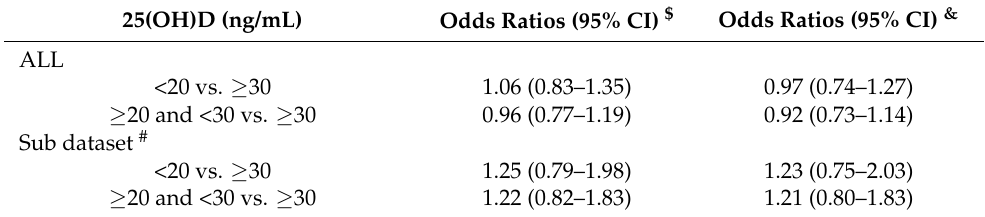
Table 1. Odds ratios from the logistic regression model for early life vitamin D levels and childhood atopic